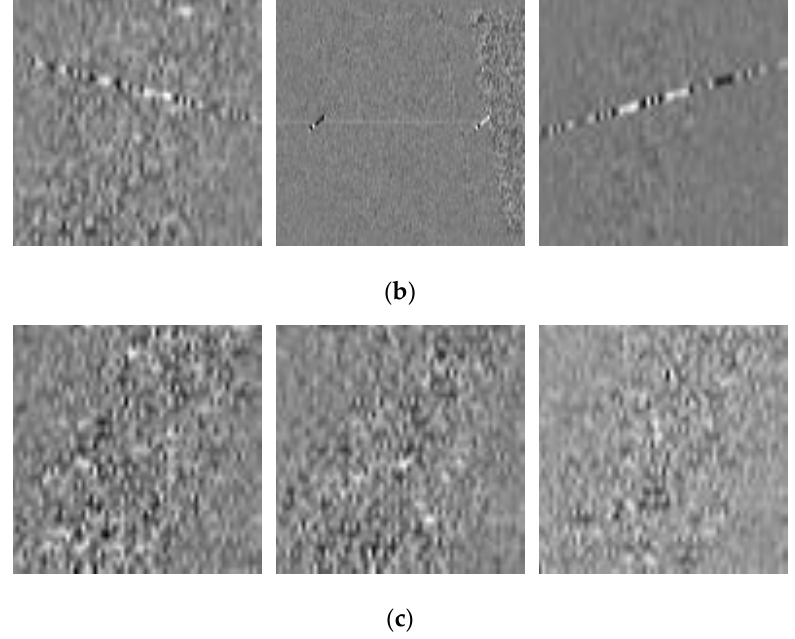
Figure 4. Samples of echoes in time–frequency representation used for training the IDN. ( a ) Shows the NBI-corrupted echoes, ( b ) shows the WBI-corrupted echoes, and ( c ) shows the echoes without interference.